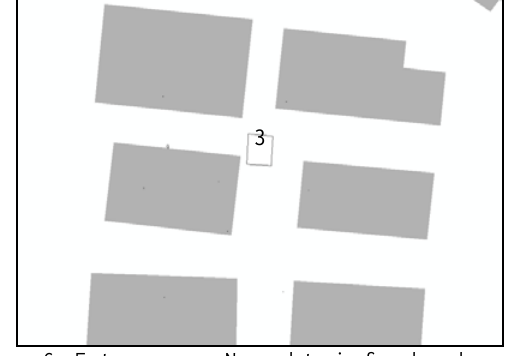
Figure 6: Extreme case. New data is found and requires updating. Quality parameters and policies should be set for deciding if the database should be